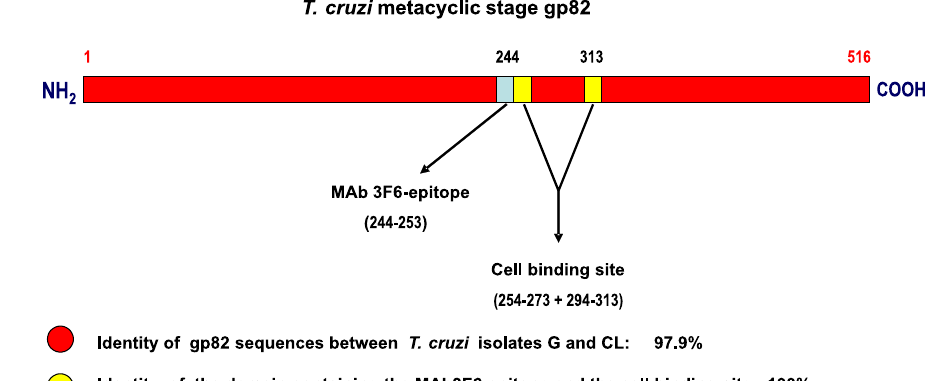
Fig. 3 – Schematic representation of T. cruzi gp82. The sequence deduced from a cDNA clone derived from MT of G isolate is represented, showing the epitope for MAb 3F6 and the host cell binding site, which were mapped using synthetic peptides and truncated recombinant constructs of gp82.